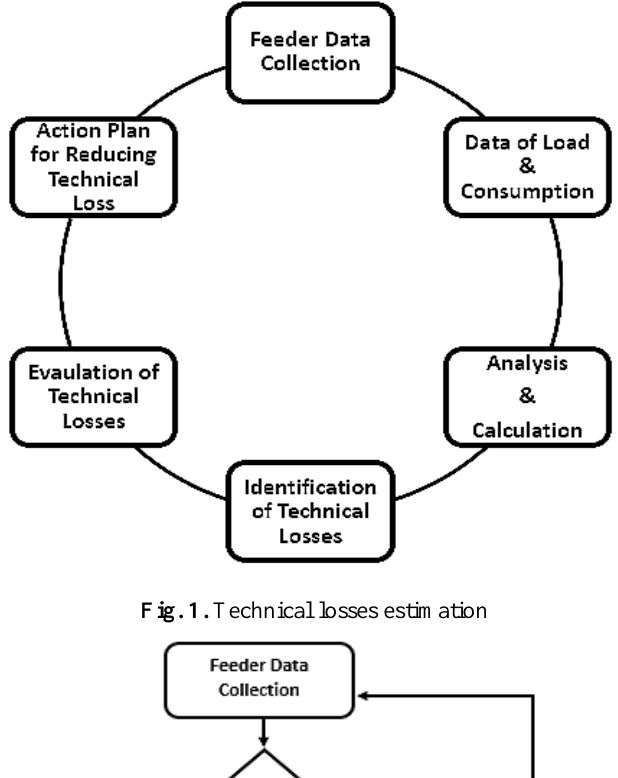
Fig. 1. Technical losses estimation